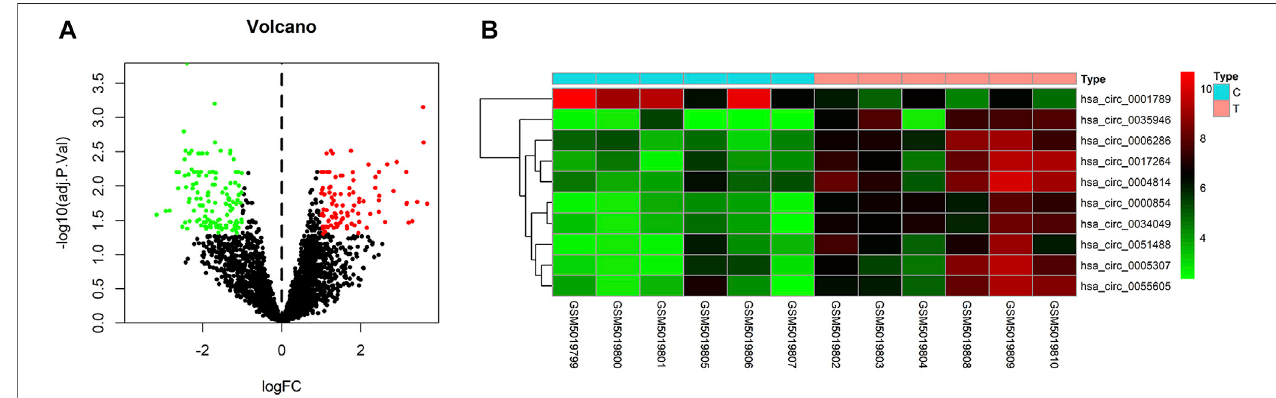
FIGURE 1 | Differentially expressed circRNAs in GSE164803. (A) Volcano plot of differentially expressed circRNAs in LIHC from the GSE164803 dataset. The red dots and green dots represent signi fi cantly upregulated circRNAs and downregulated circRNAs, respectively (adjusted p < 0.05 and |logFoldChange| > 1). The black dots are circRNAs without signi fi cant changes. (B) Heatmap of 10 potential circRNAs (|logFoldChange| > 3). The intensity increased from green (relatively lower expression) to red (relatively higher expression). C, control tissues; T, tumor